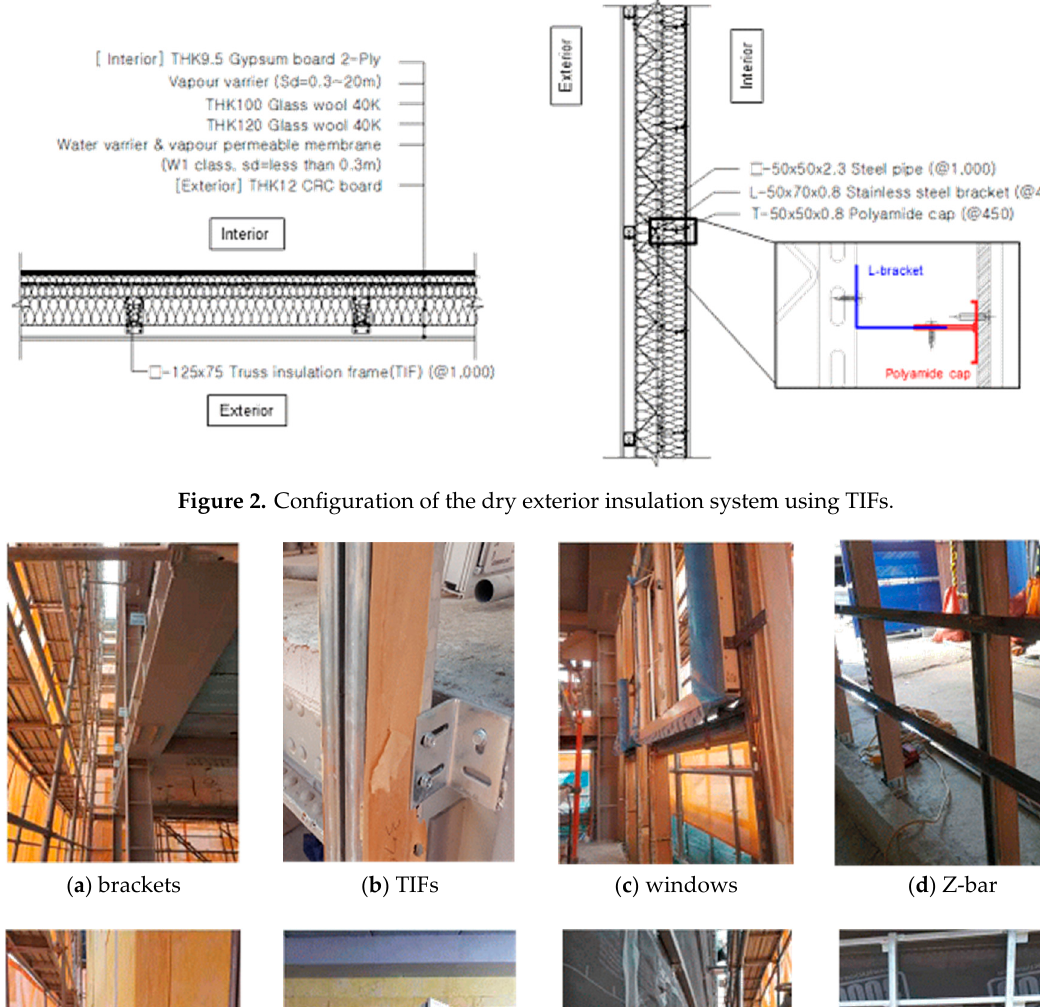
Figure 2. Configuration of the dry exterior insulation system using TIFs.